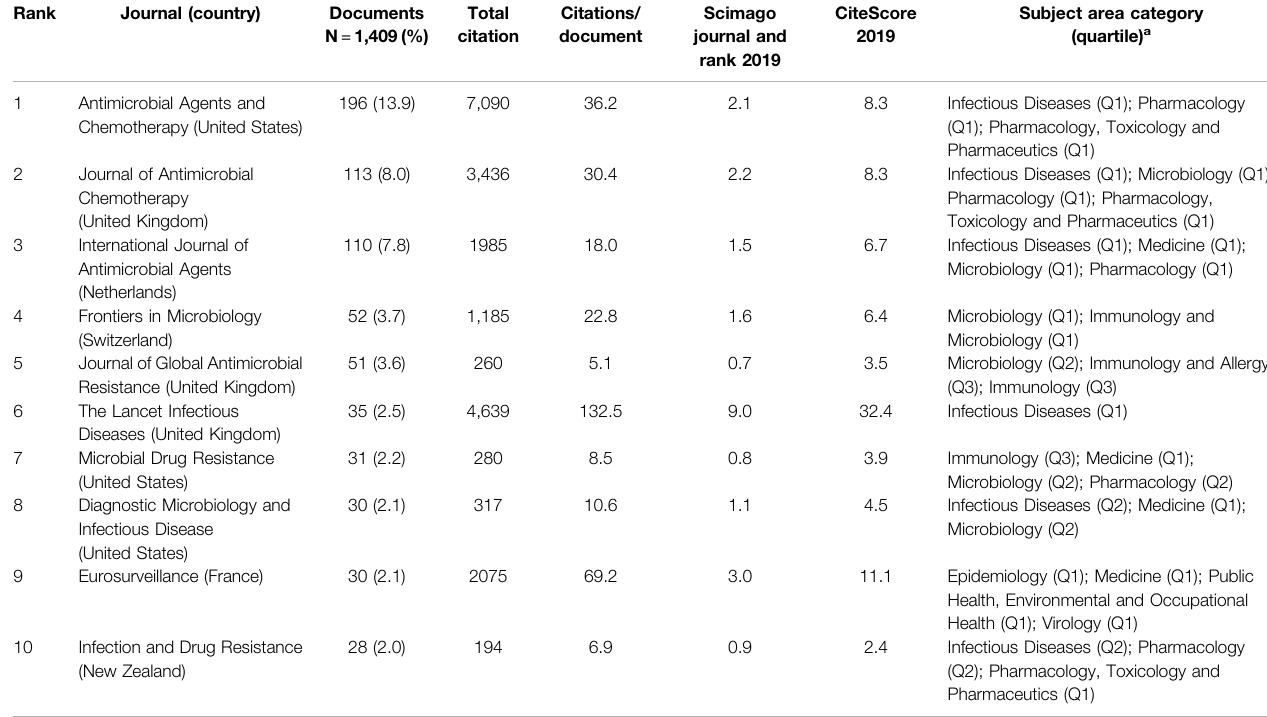
TABLE 5 | Top ten journals publishing on polymyxin resistance (2010 – 2019).